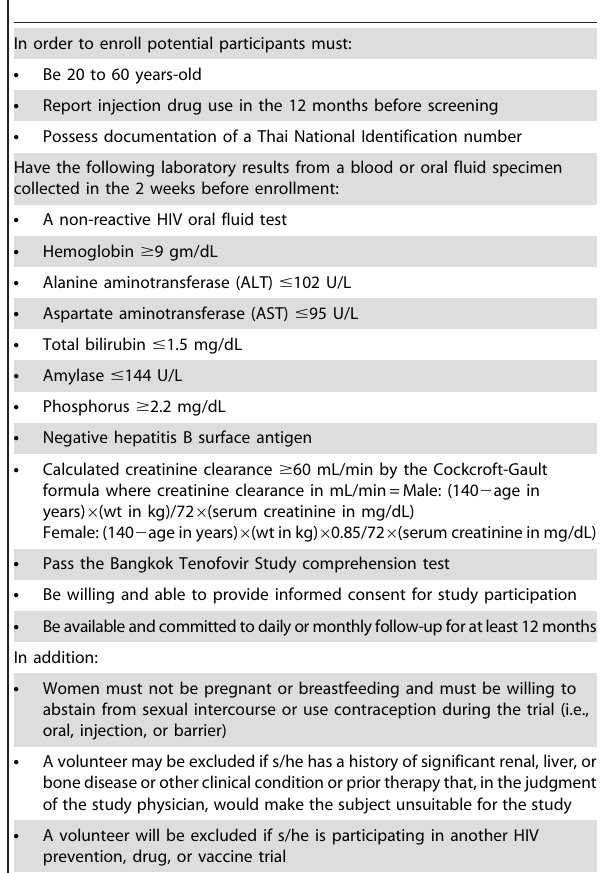
Table 1. Eligibility requirements for the Bangkok Tenofovir